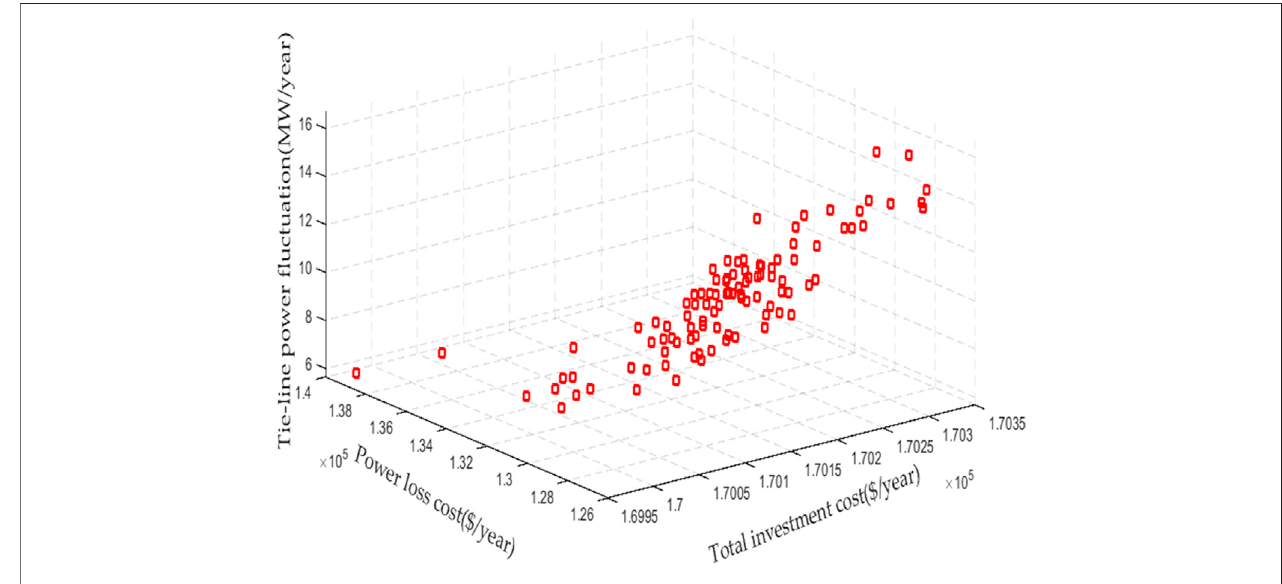
FIGURE 4 | Three-objective Pareto front results.